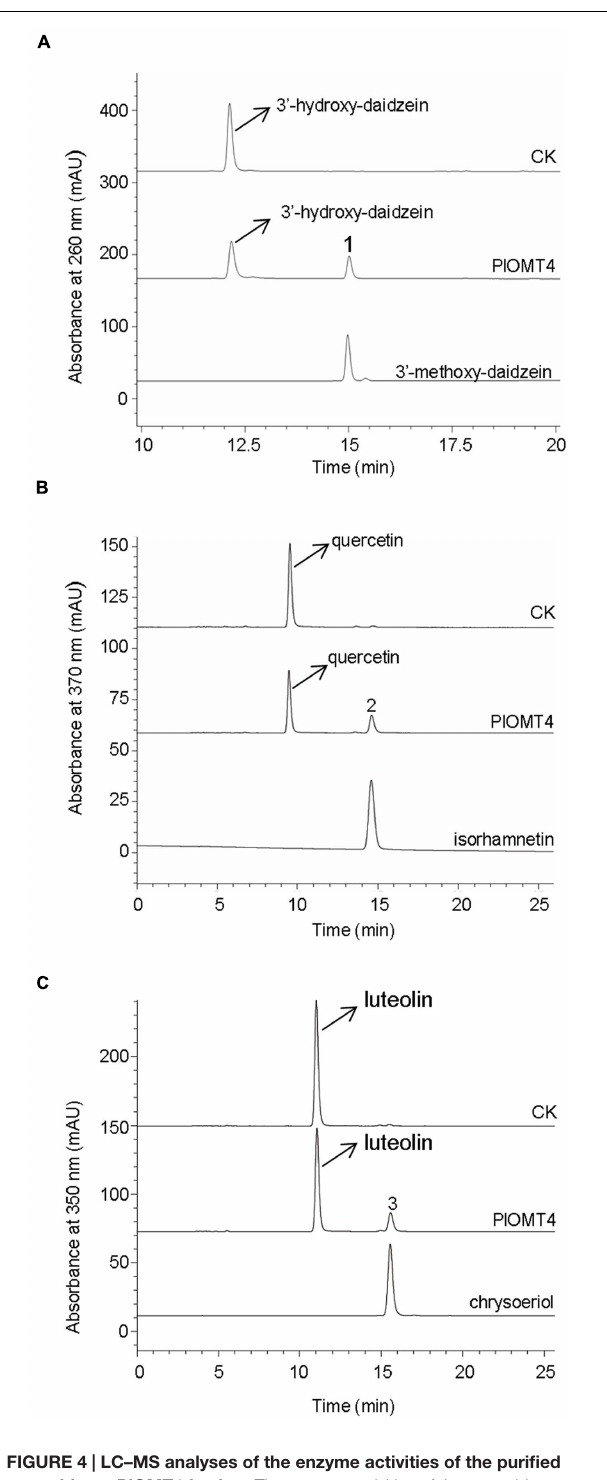
FIGURE 4 | LC–MS analyses of the enzyme activities of the purified recombinant PlOMT4 in vitro. The enzyme activities of the recombinant PlOMT4 were shown for the conversion of 3 (cid:48) -hydroxy-daidzein to 3 (cid:48) -methoxy-daidzein (peak 1; A ), the conversion of quercetin to isorhamnetin (peak 2; B ), and the conversion of luteolin to chrysoeriol (peak 3; C ). The mass spectra of the peaks 1–3 with their corresponding authentic standards were shown in Supplementary Figure